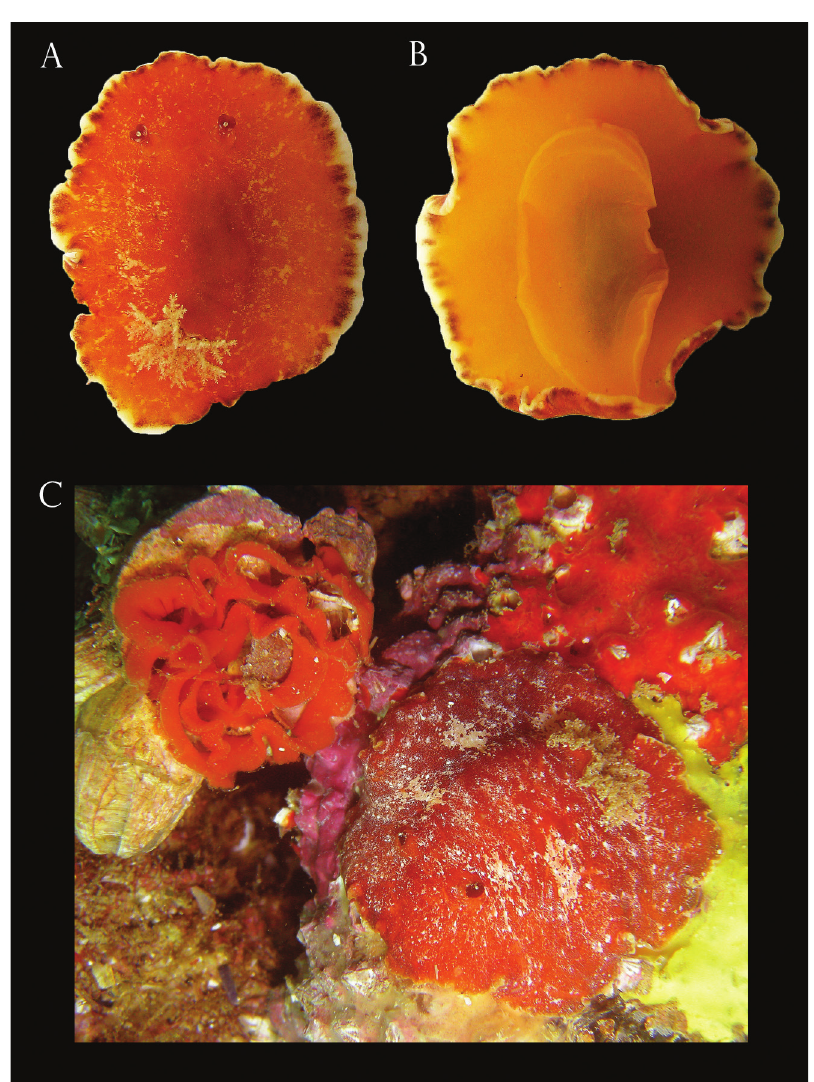
Figure 7. Platydoris guarani , living animals. A. Dorsal view, specimen from Papagaio, Cabo Frio, Rio de Janeiro (MZSP 97331). B. Same, ventral view. C. Living animal with spawning, specimen from Enseada da Meia Lua, Cabo Frio, Rio de Janeiro (MZSP 97625). All photograph by V.